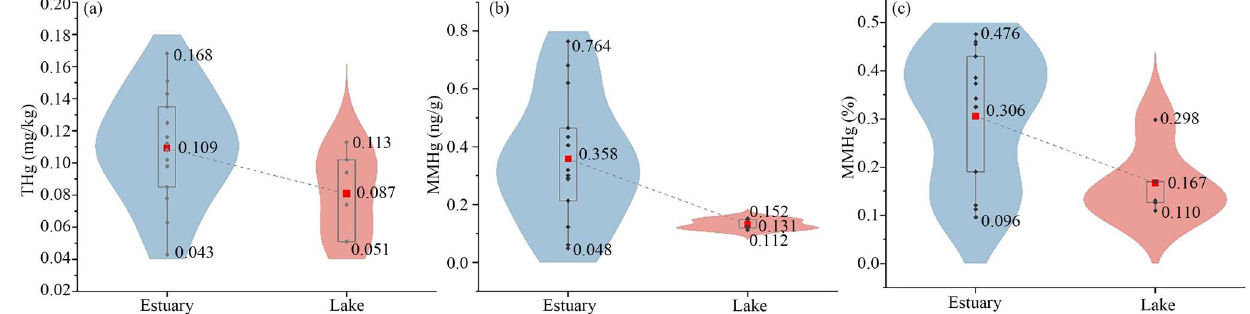
Figure 3. The content of ( a ) total Hg, ( b ) methylmercury, and ( c ) methylation rate of Hg.